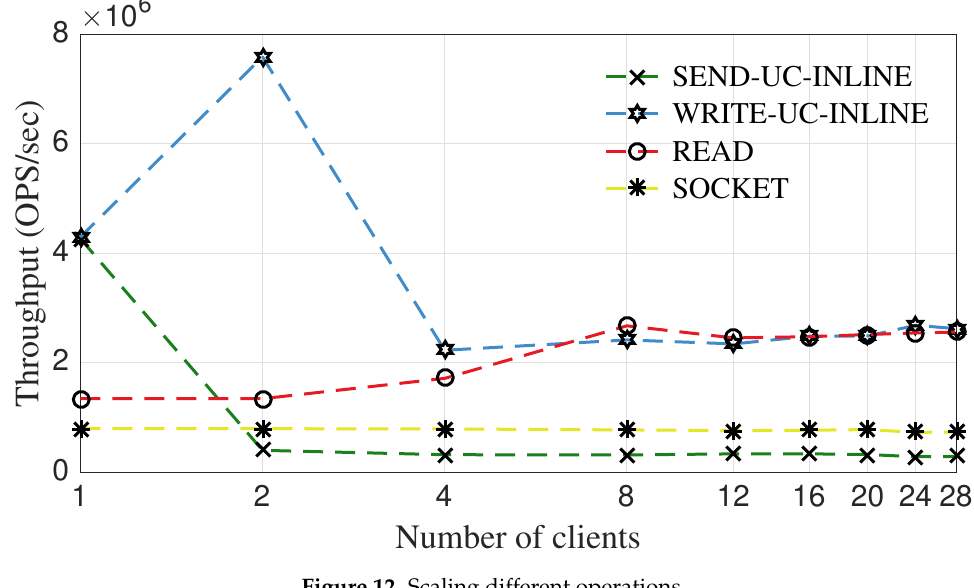
Figure 12. Scaling different operations.